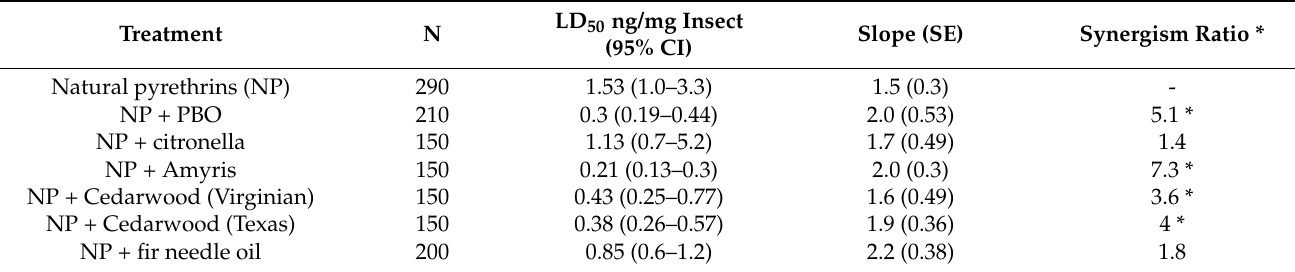
Table 3. Dose–response statistics for natural pyrethrins applied alone and in combination with select candidate synergists and their respective synergist